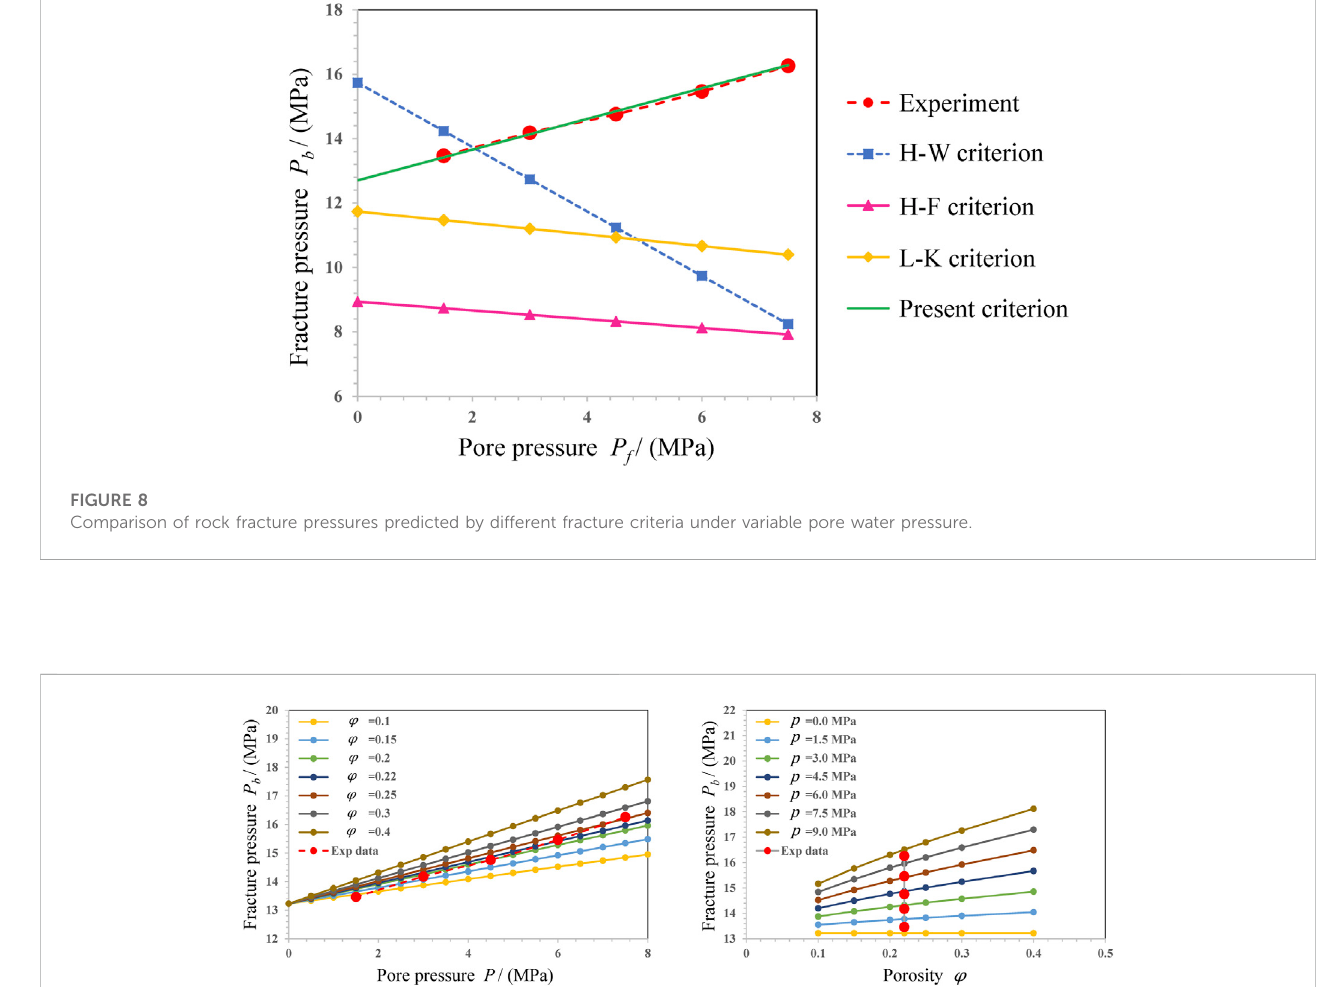
parameters. In the following part, we discuss the effects of rock porosity, pumping capacity and particle size on rock fracture pressure.